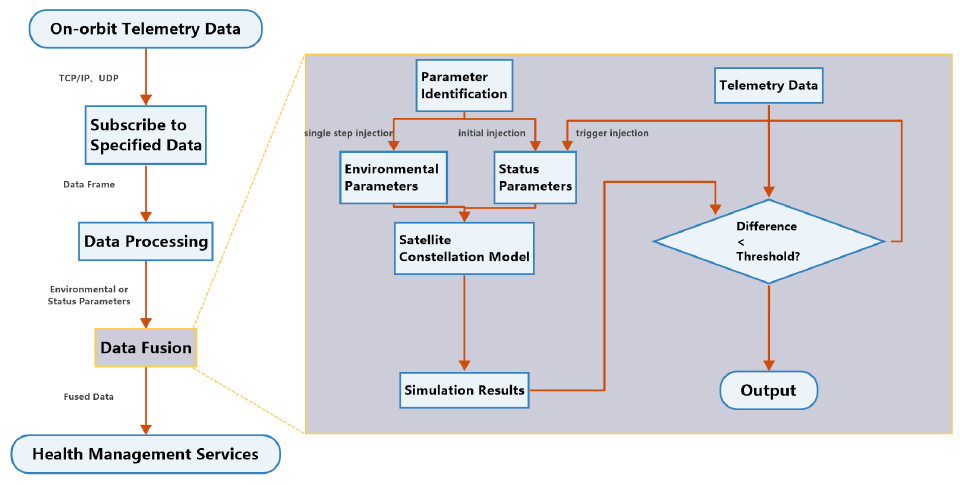
Figure 7. Flow chart of data